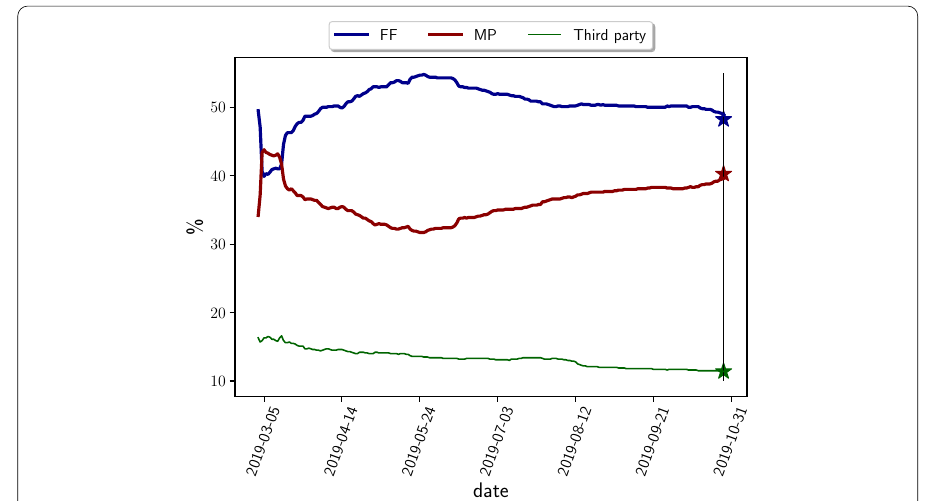
Fig. 14 Cumulative Model 3 prediction of the AI model and comparison with primary on August 11, 2019 and general election results on October 27, 2019. Model 3 is the best fit to the real